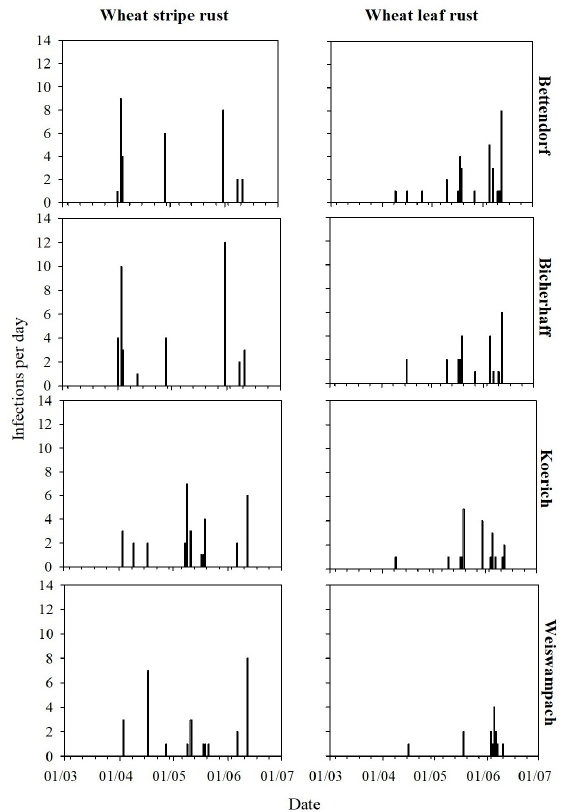
Figure 3. Simulated infection events for wheat stripe rust (WSR) and wheat leaf rust (WLR) at the experimental sites during March and July 2019. Simulations for WSR and WLR were carried out using the threshold-based weather models described in El Jarroudi et al. [43] and El Jarroudi et al. [45], respectively. For WLR, UAV-derived estimates varied throughout the monitoring period and according to each of the sites (Figure 5). The highest WLR severities were found at Bettendorf. Such disease levels can be explained by favorable nighttime weather conditions in early June (WLR infection events are generally linked to conducive nighttime in the GDL [5,45] and the cultivars’ susceptibility to the